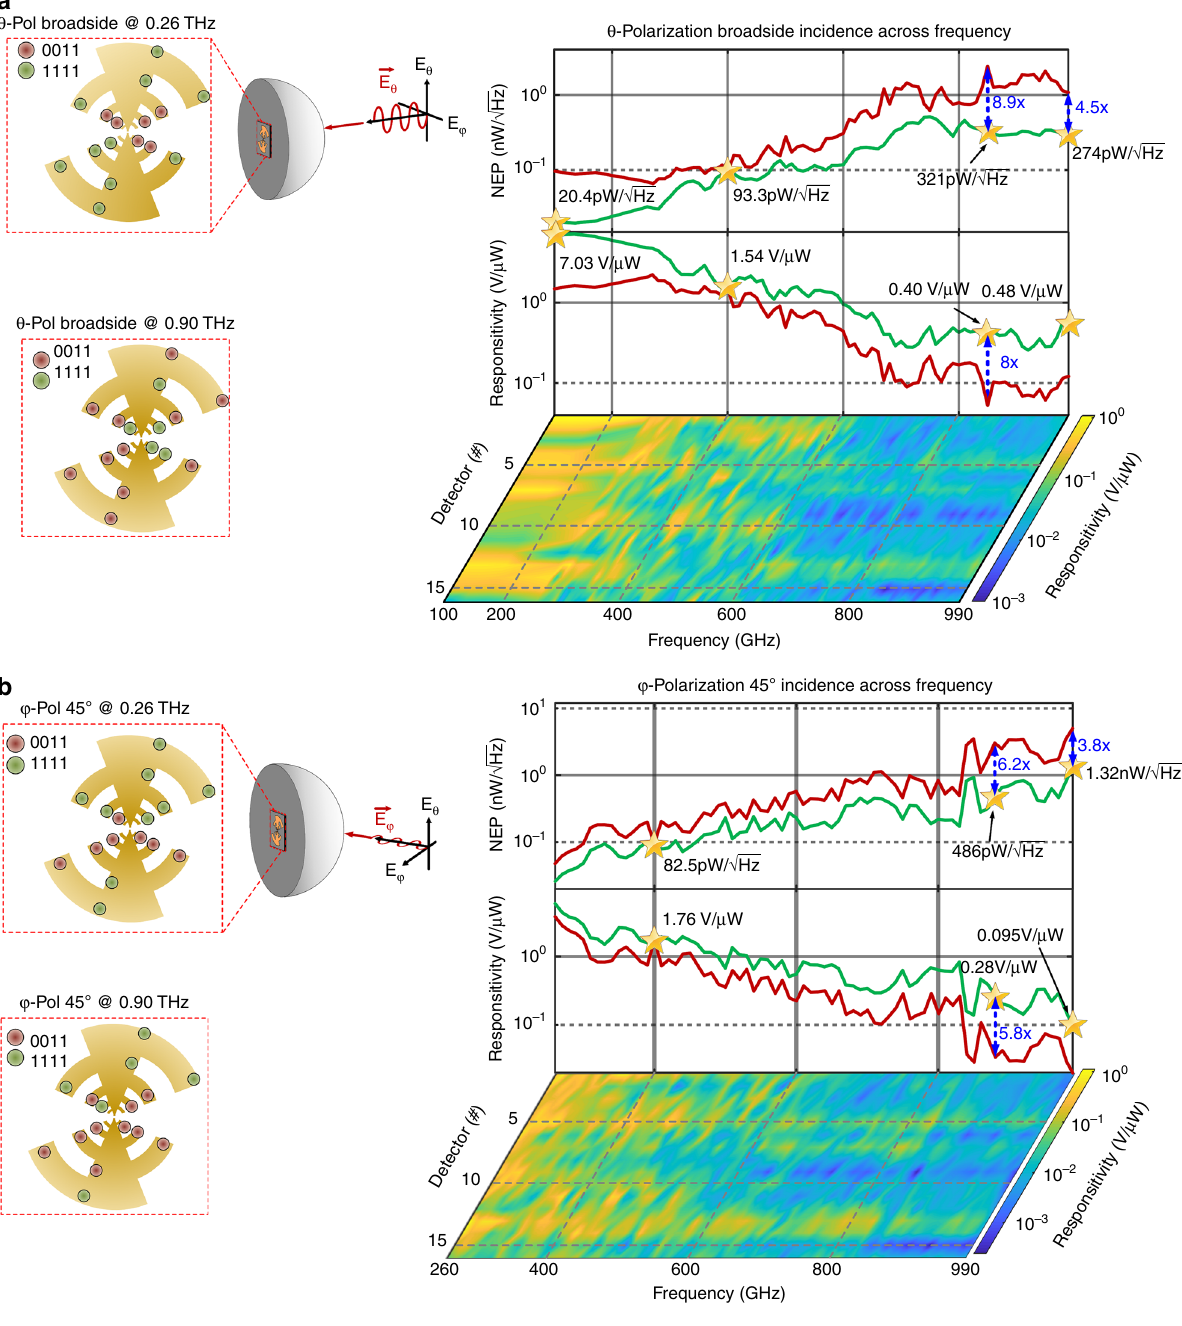
The fi gure compares the optimized performance across the frequency range against a static con fi guration for broadside incidence at 0.4 THz. The green line represents the overall sensor performance as the detector states are optimized for each incident frequency. The red line represents the sensor performance across frequency for a fi xed optimal con fi guration at 0.4 THz. As can be